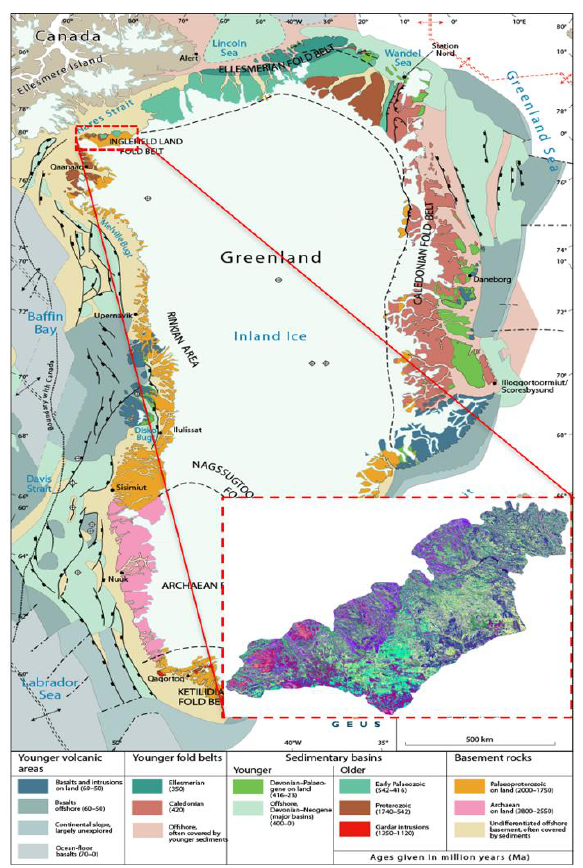
Figure 1. Location of the study area (Inglefield Land) in north- west Greenland. Geological map from Geological Survey of Denmark